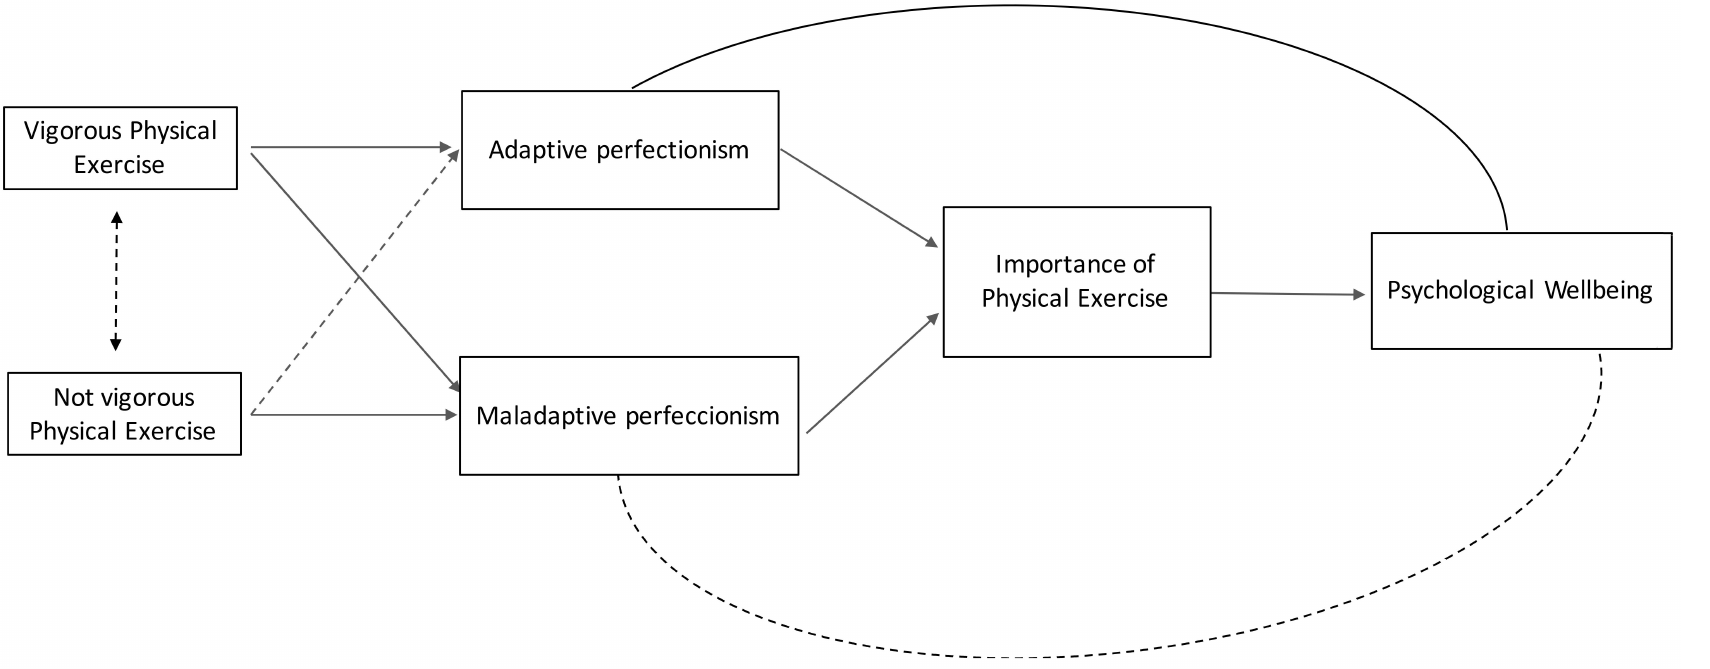
Figure 1. Hypothesized model on the practice of physical exercise, perfectionist patterns, and psychological well-being in